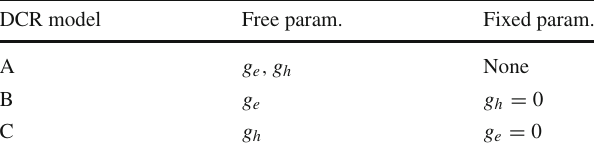
Table 4 A summary of the α delayed charge collection models stud- ied. g e and g h are the fraction of the electron and electron-hole charge collection signals that contribute to the delayed event energy DCR